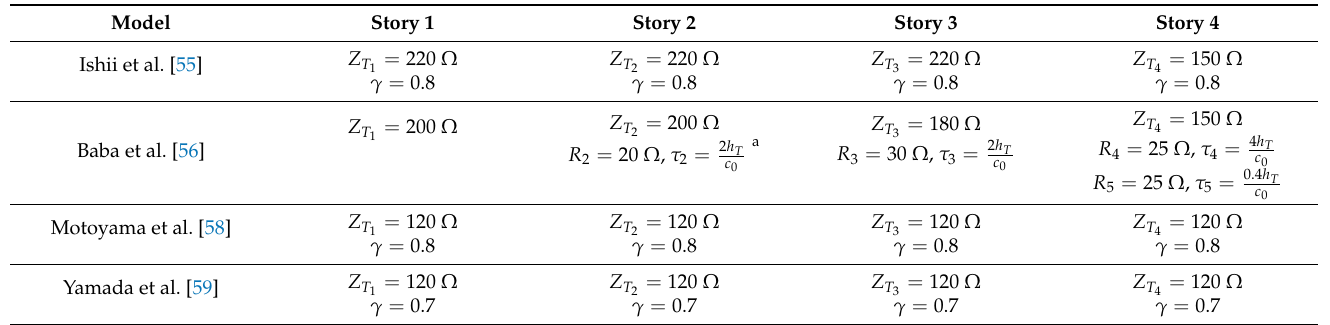
Table 4. Parameters required by the main multistory models presented in Section 4.3. Model Story